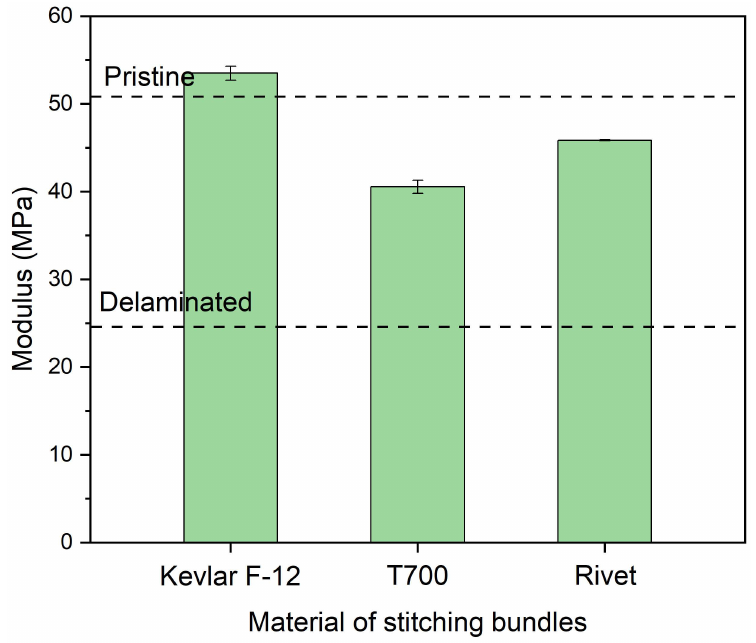
Figure 17. Modulus of plates stitched by Kevlar F-12 bundles, T700 fiber bundles, and aluminum rivets with the parameters w = 0.8, d = 2.5, and n = 6.